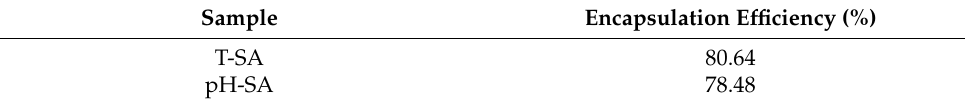
Table 2. Encapsulation efficiency (%) of the obtained systems of nanocarrier–salicylic